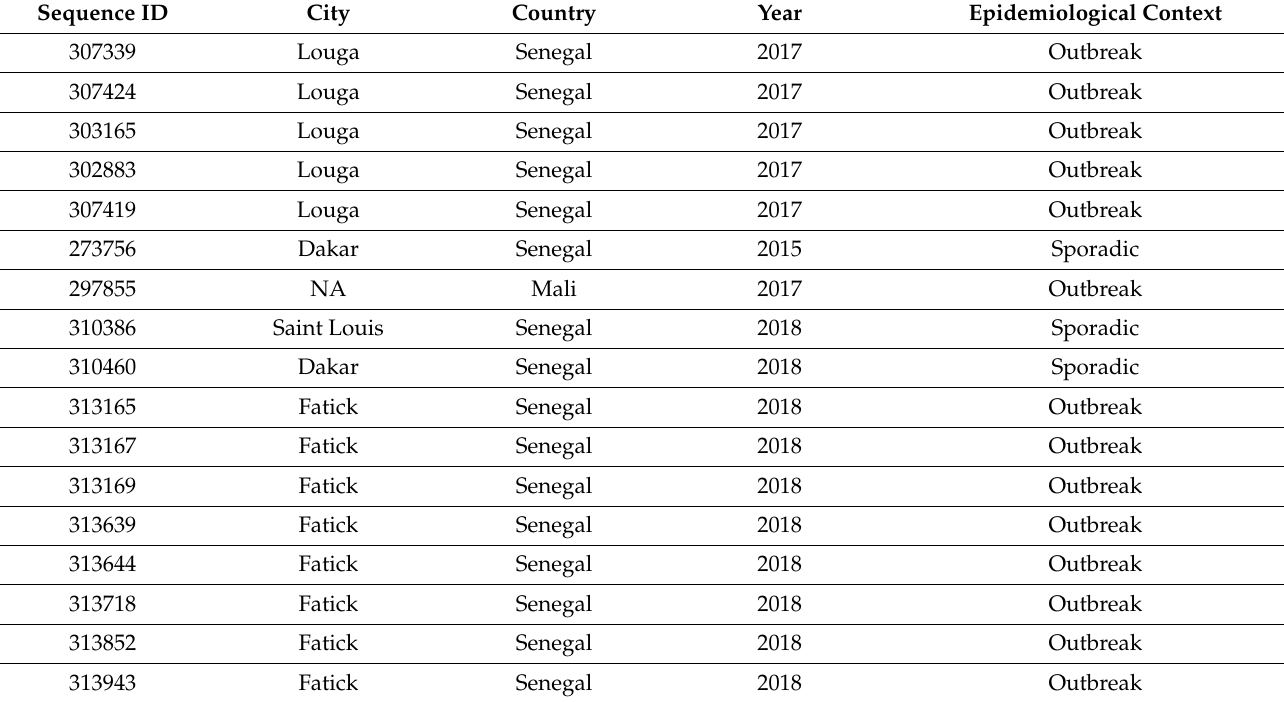
Figure 1. A map showing the locations where DENV − 1 positive samples were sampled. The red dots correspond to outbreak samples and the blue dots to sporadic samples. Table 1. Sequenced strains during this study .